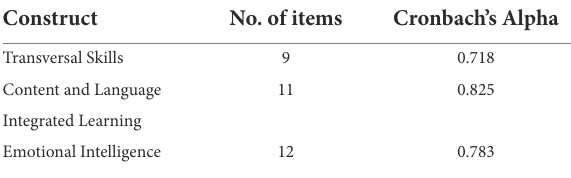
TABLE 2 Results of the reliability rest.